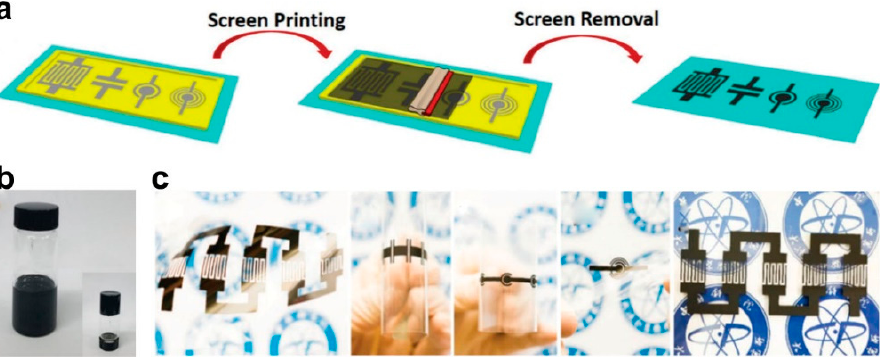
Figure 6. ( a ) Schematic of the screen printing process for fabricating the rGO based flexible on-chip MSCs; ( b ) Digital image of the prepared rGO ink; ( c ) Photography of the fabricated MSC devices. The figure has been reproduced with permission from The Royal Society of Chemistry [60].